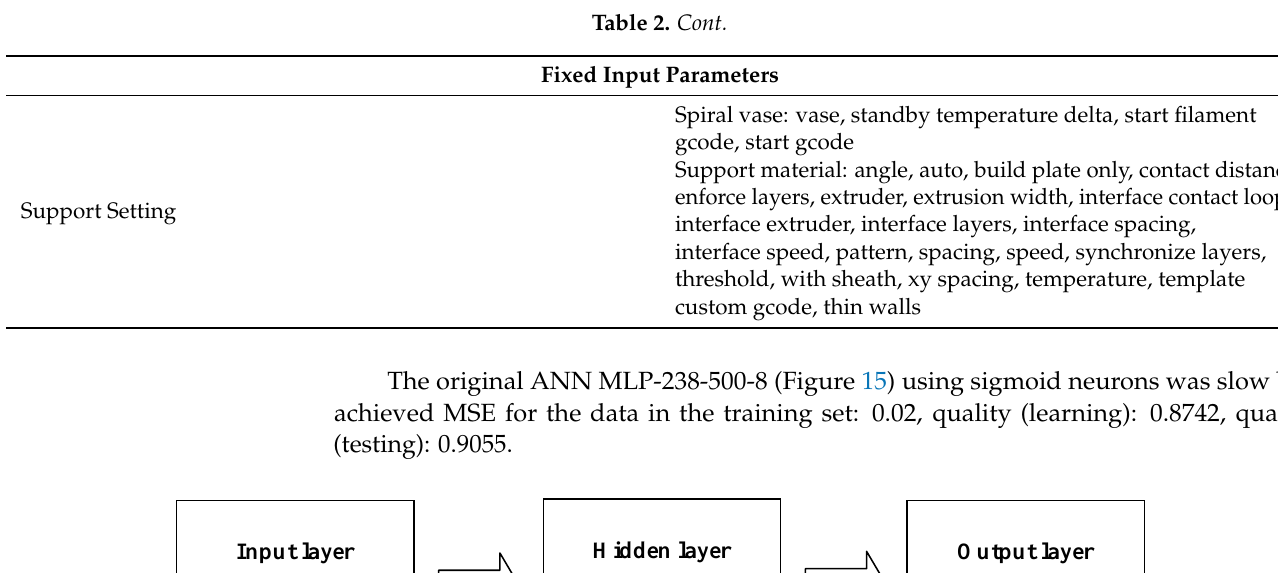
Figure 15. Optimal full-size ANN.